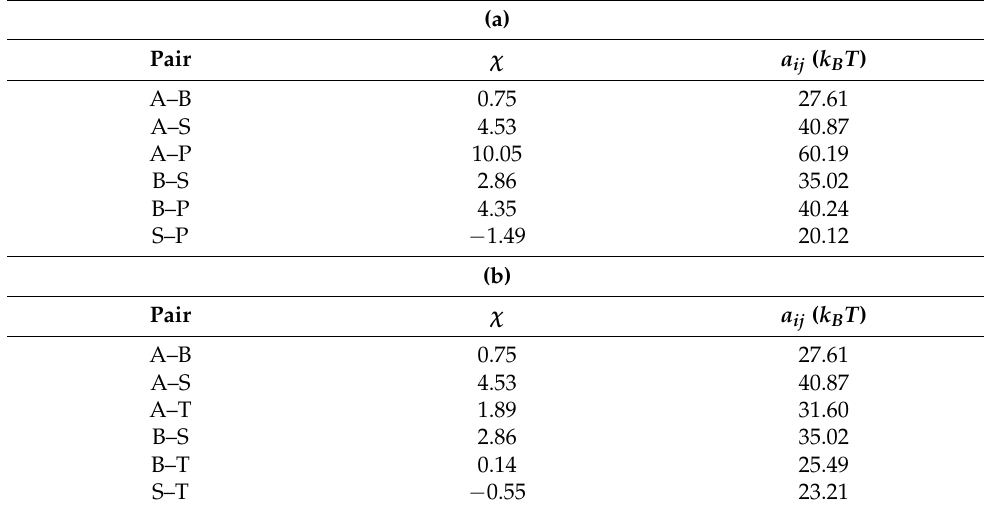
Table 1. Calculated Flory–Huggins ( χ ) parameters and corresponding repulsion parameters ( a ij ) of DPD simulation for each pair in ( a ) Nafion–PVPA and ( b ) Nafion–PVTri